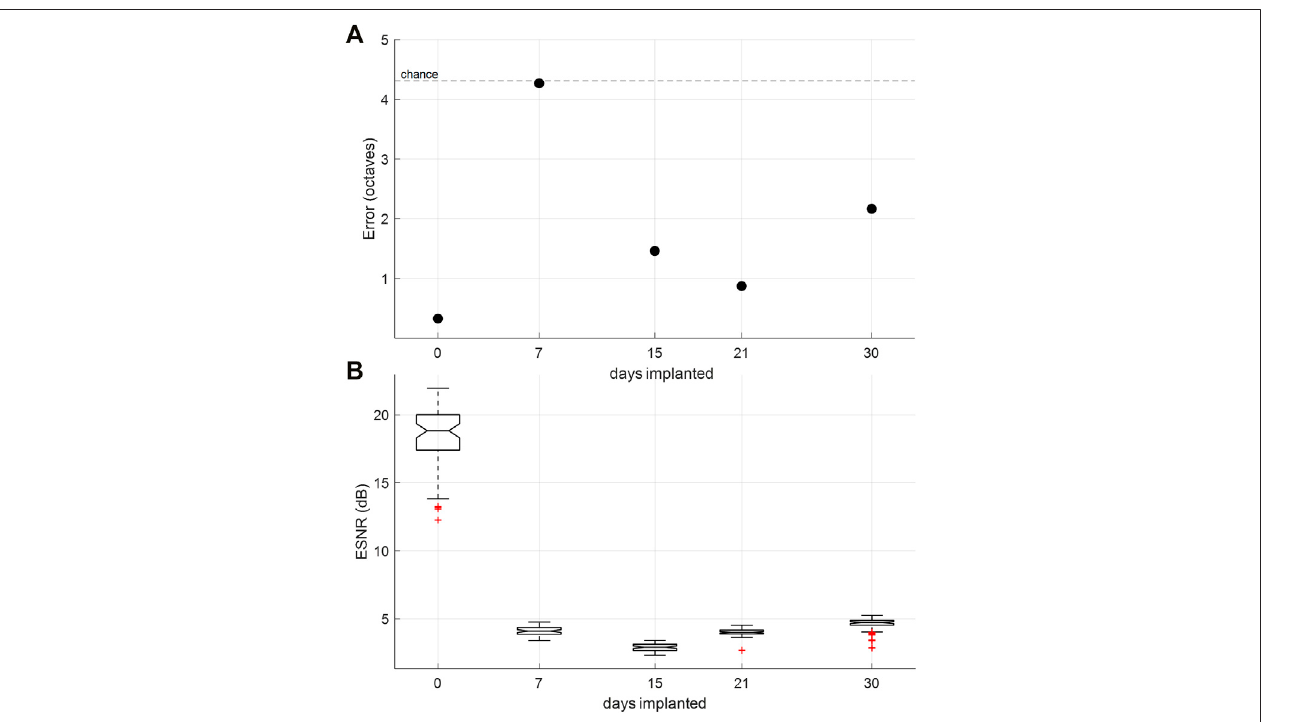
FIGURE7| Chronic in-vivo recordings. (A) Tone-decoding errorovertime.Decoding 13tonesplayed (0.5 – 32 kHz)at half-octavespacing, whichprovides chance at 4.31 octaves. (B) ESNR over time measured by ratio of SNR during evoked potential to SNR during idle behavior (200 m of recording prior to auditory stimulus).